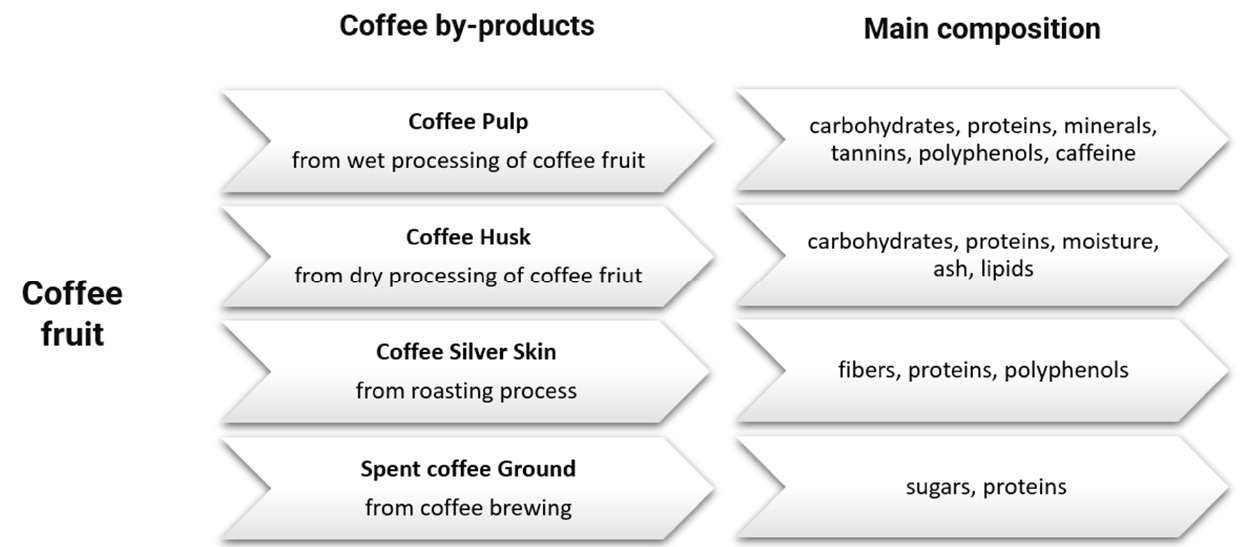
Figure 3. Schematic representation of coffee by-products and their main components. Own compi- tion based on literature data lation based on literature data [14].